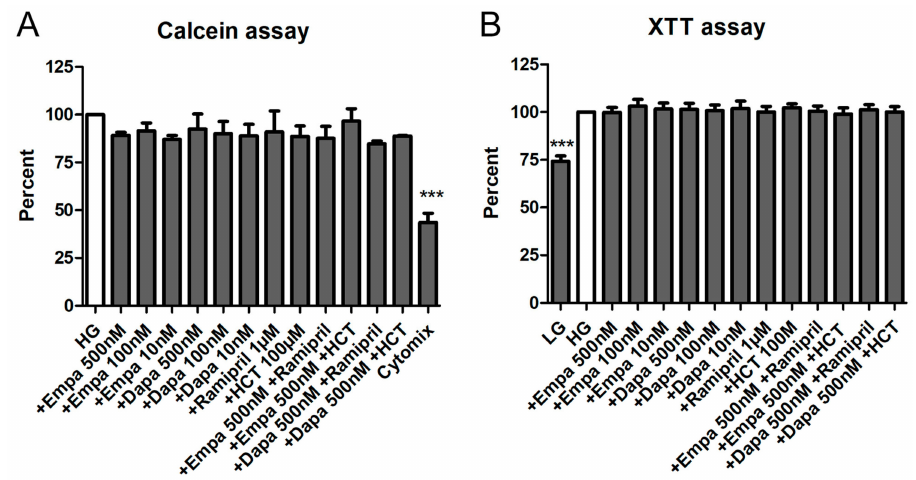
Figure 3. Cell viability assays. The PTCs cultured in 96-well plates were incubated for 6 d in media containing empa- or dapagliflozin and co-medications. No significant e ff ects of the di ff erent pretreatments on the cell viability were detected. ( A ) Calcein assay. After loading with calcein-AM for 1h, fluorescence was measured immediately using a fluorescence reader (ex 485 nm, em 538 nm, arbitrary units, calculated as percent in relation to the control (high glucose medium: HG), mean ± SD, n = 5). Cells incubated with a mixture of cytokines (Cytomix) were used as a negative control (*** p < 0.001). ( B ) XTT assay. The XTT assay was performed and optical density (OD) was measured in a microplate reader at 490 vs. 650 nm (arbitrary units, calculated as percent in relation to the control (HG), mean ± SD, n = 4). Cells cultured in low glucose medium 199 (LG) were used as a negative control (*** p < 0.001).